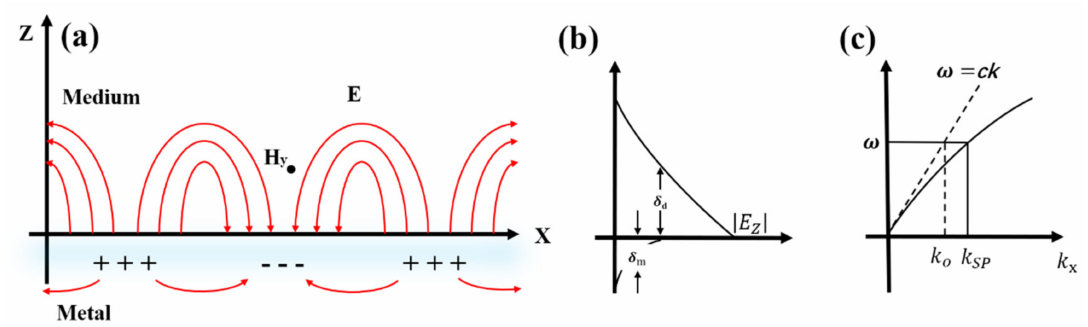
Figure 2. Electric field properties of SPP at the interface between dielectric and metal surface: ( a ) Coupling and electronic oscillation of SPP electromagnetic waves. ( b ) The electric field component of the SPP is bound on both sides of the interface and decays exponentially. ( c ) Dispersion plot of